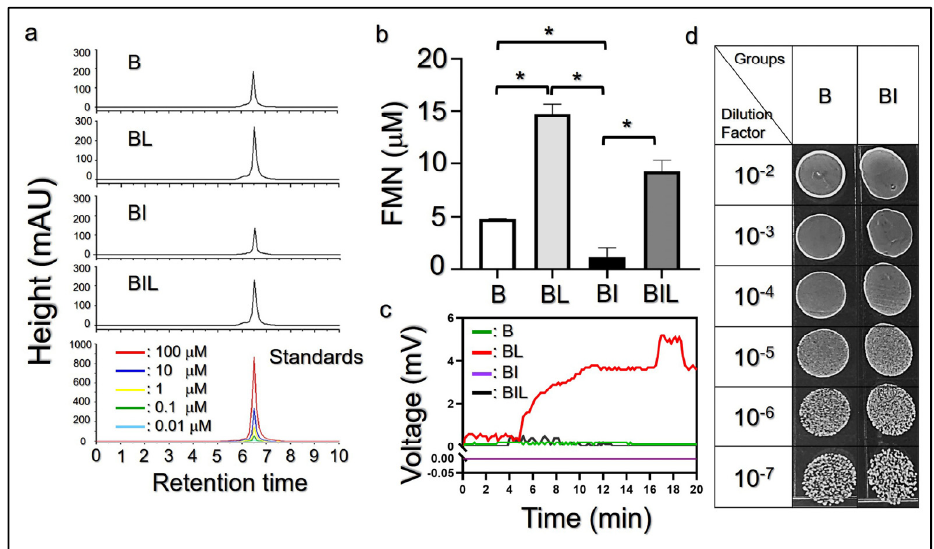
Figure 3. Effect of roseoflavin on the FMN production of L. plantarum MA. ( a ) HPLC chromatograms of FMN produced from L. plantarum MA treated with 2% lactulose (BL), 1-µM roseoflavin (BI), or 1-µM roseoflavin + 2% lactulose (BIL). Bacteria treated with normal MRS broth (B) was employed as the control. The chromatograms of the standard FMN in various concentrations exhibit that the FMN peak is appeared at approximately the 6.5th min. ( b ) Quantification of the FMN of each group shown in ( a ). Values are the mean ± SD (n = 3). * p < 0.05. ( c ) Patterns of electricity productions of L. plantarum MA under treatment of nothing (i.e., MRS only; B), lactulose (BL), roseoflavin (BI), or roseoflavin + lactulose (BIL) for 20 min. ( d ) Photographic images of the colonies of L. plantarum MA which were pretreated with nothing (B) or roseoflavin (BI) for 24 h before being subjected to the colony assay. Images in the six rows represent the colony forming conditions made by seeding 10 2 –10 7 -fold bacterial dilutions. All images were photographed using a digital camera after cultivation on the MRS agar plates for 24 h.